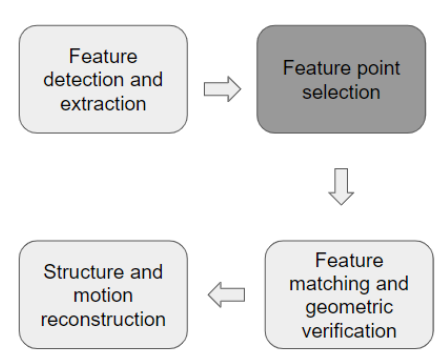
Figure 7. COLMAP SfM sequential processing pipeline with the addition of the new step of manual selection of specific feature